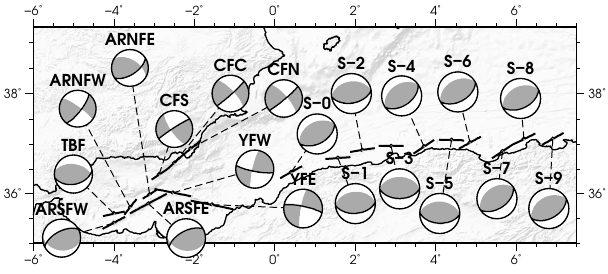
Fig. 1. Seismic sources modelled as probable tsunamigenic worst cases for the Spanish Mediterranean coast (taken from ´Alvarez- G´omez et al., 2010a,b). The thick lines are the surface trace of the faults and the focal mechanisms represent the rupture characteris- tics. The black line of each double couple is the fault